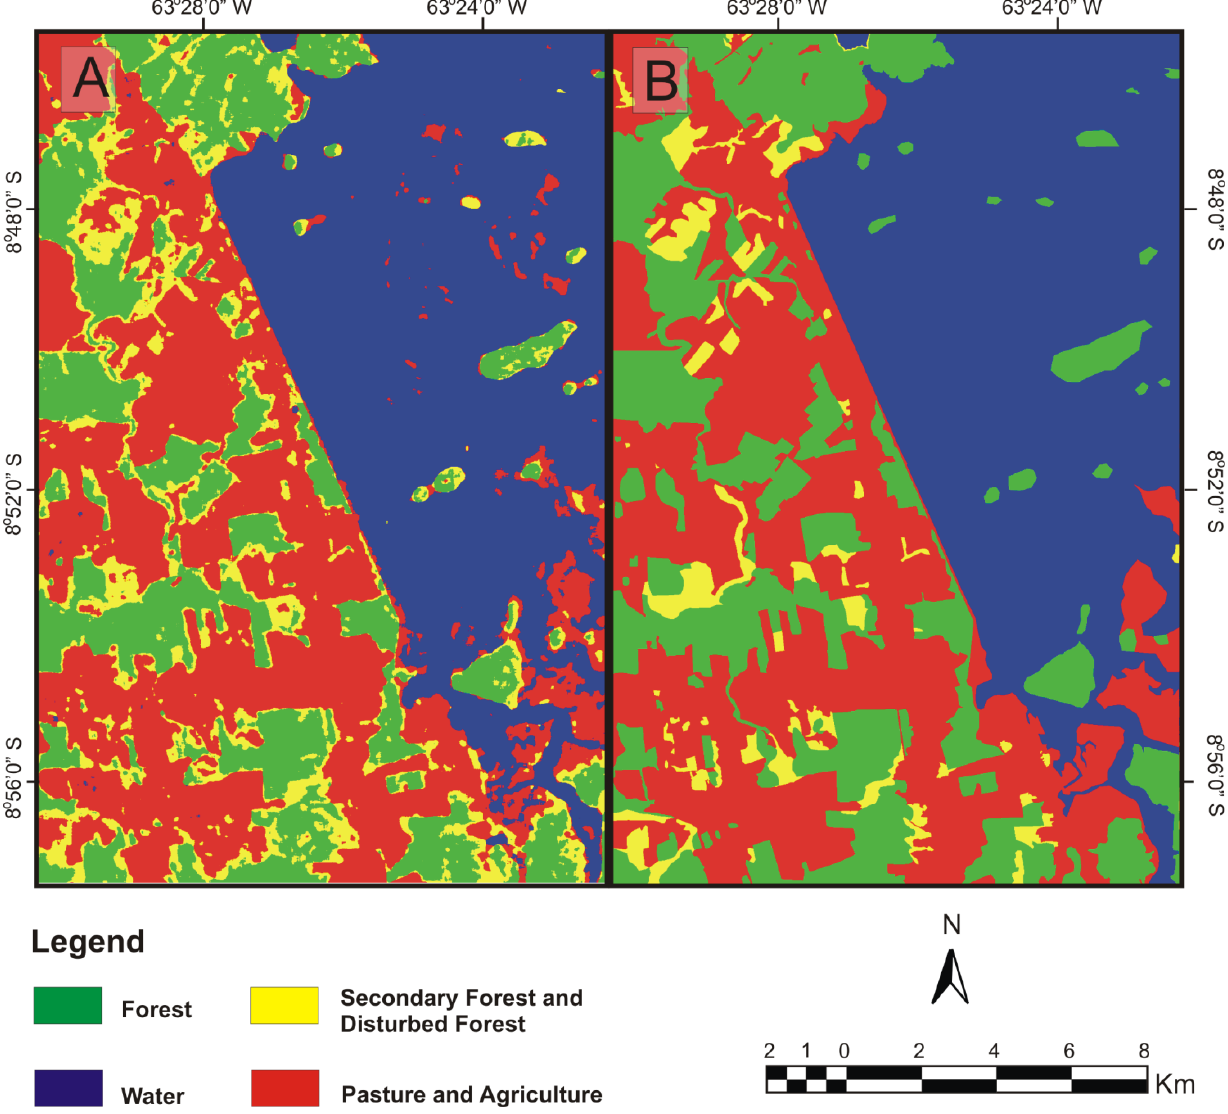
Figure 12. Classified maps using ( A ) the Spectral Correlation Mapper from the probability density curves; and ( B ) visual interpretation from high-resolution optical images.